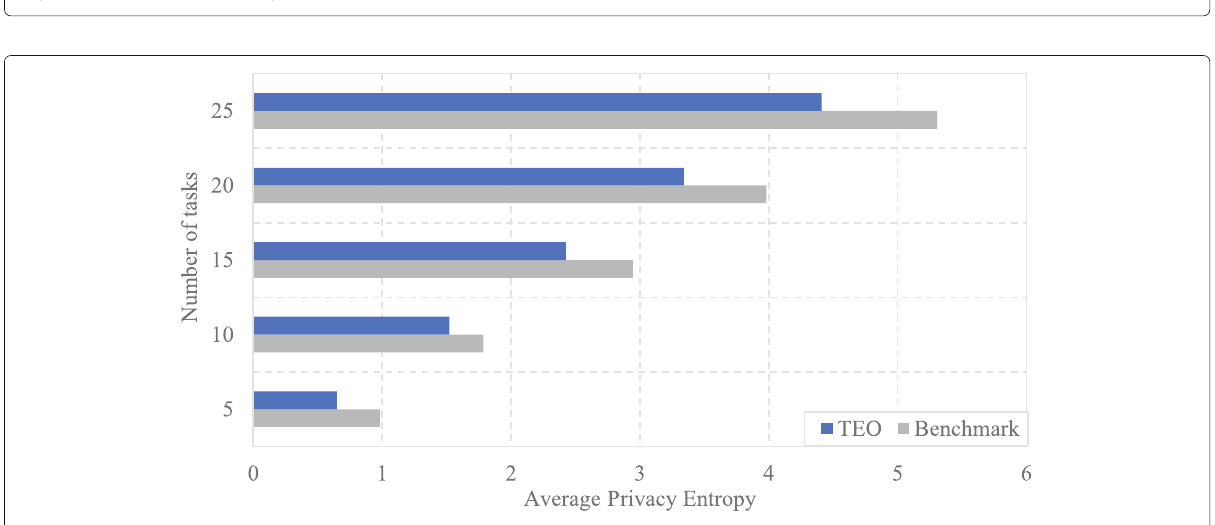
Fig. 10 Comparison of the average privacy